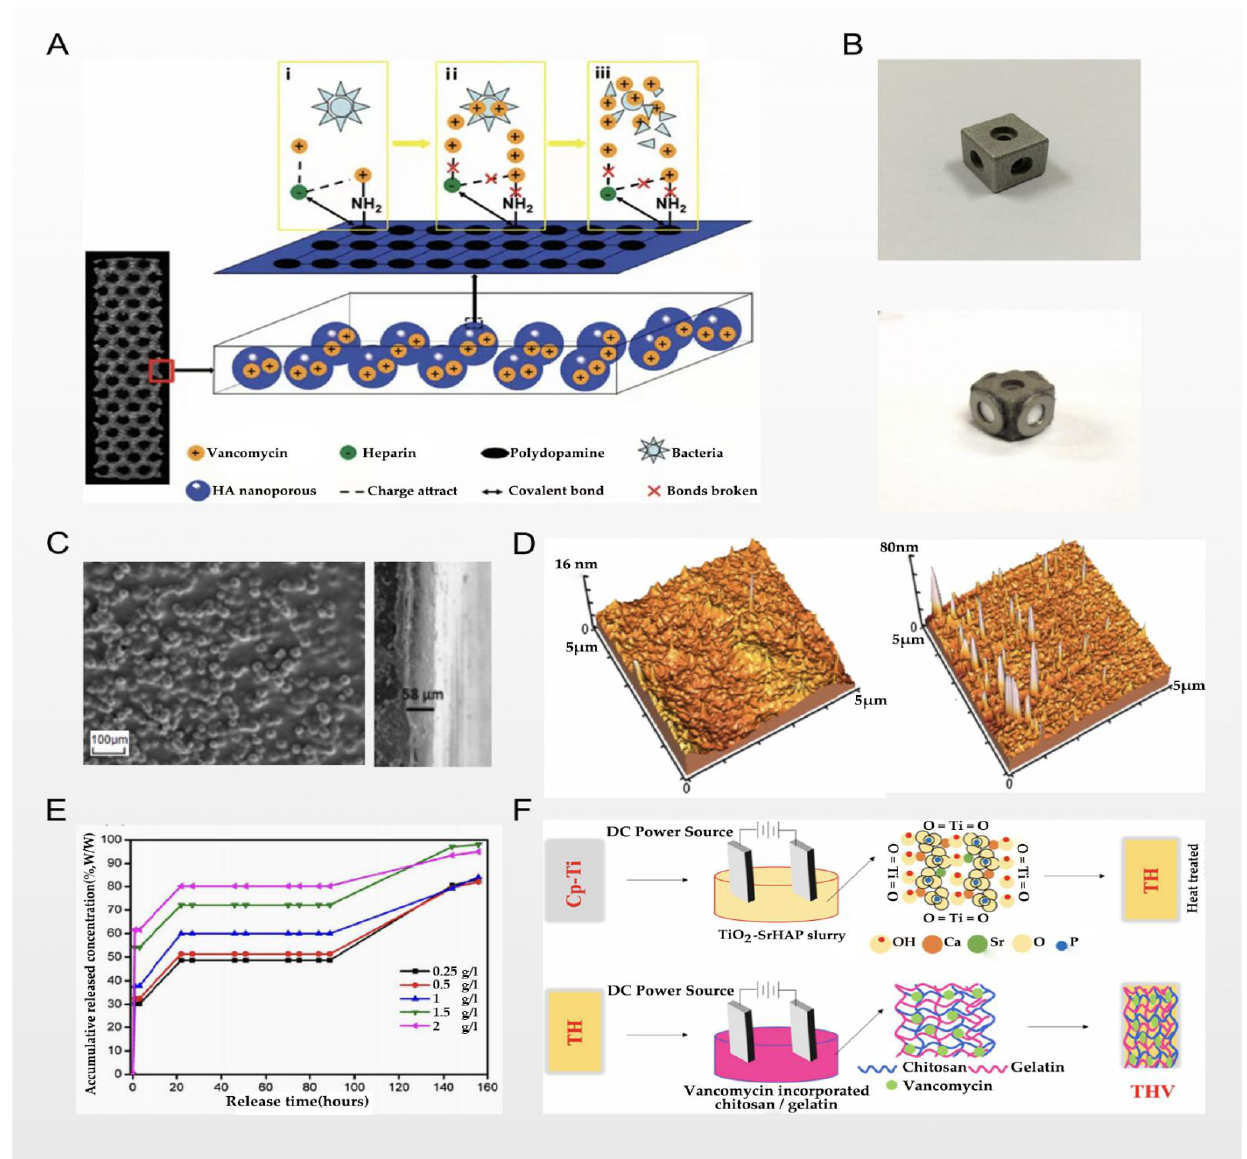
Figure 3. ( A ) Experimental scheme of Zhang et al.; reprinted with permission from [29]; copyright 2020 The Royal Society of Chemistry. ( B ) Intuitive structure of the designed material; reprinted with permission from [50]; copyright 2015 Martin B. Bezuidenhout et al. ( C ) Top-view and cross-sectional SEM images of the material; reprinted with permission from [30]; copyright 2014 Elsevier B.V. ( D ) Representative topographical AFM images of chitosan and a drug-eluting composite coating; reprinted with permission from [30]; copyright 2014 Elsevier B.V. ( E ) Drug release curve of experimental and control groups; reprinted with permission from [30]; copyright 2014 Elsevier B.V. ( F ) Experimental scheme of Nancy et al.; reprinted with permission from [58]; copyright 2018 Elsevier